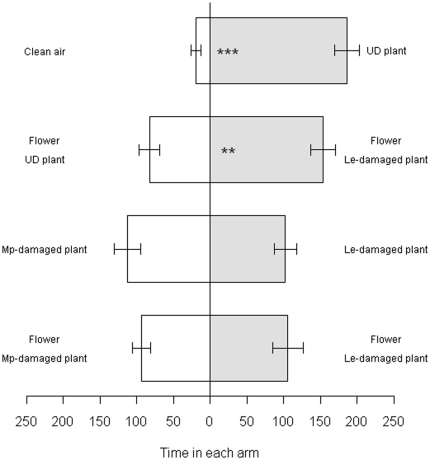
Response of aphid parasitoid D. rapae to odours from S. alba in a two-way olfactometer.Figures represent mean time spent in each arm in seconds (± s.e.). UD: undamaged flowering S. alba. Le: L. erysimi. Mp: M. persicae. ** 0.01<p<0.001; *** p<0.001.